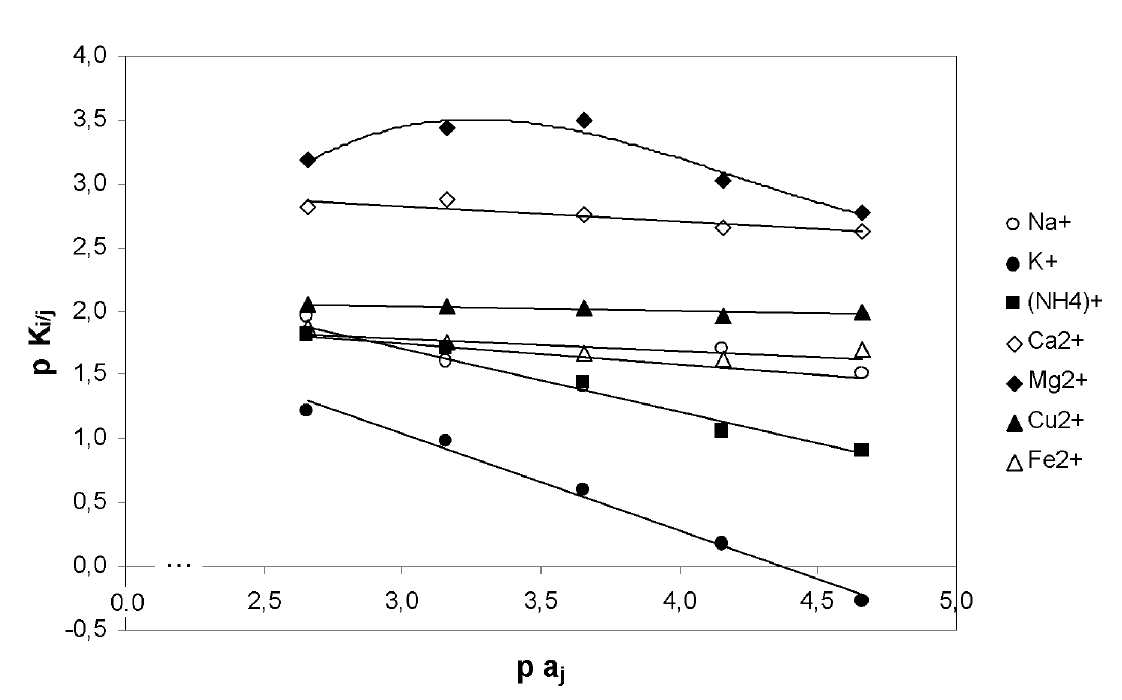
Fig. 4 The curves of changes of electrode selectivity coe¯ cient for several inorganic